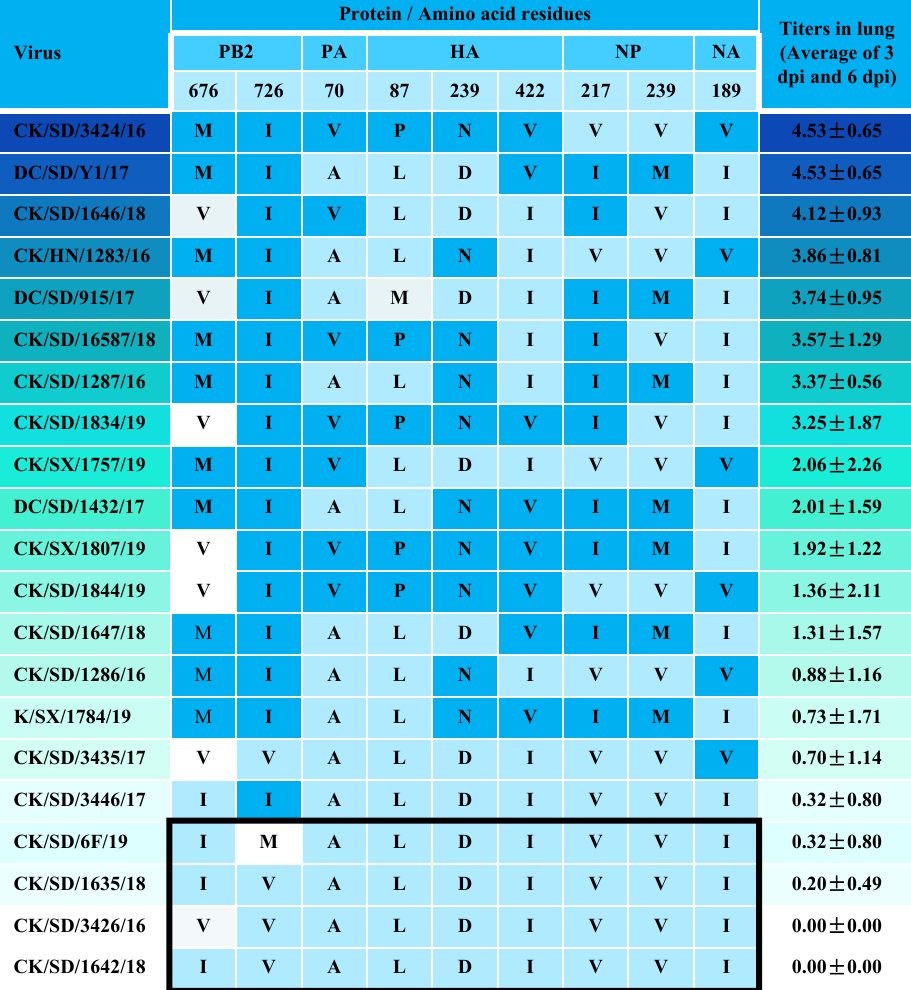
Figure 6. Amino acid residues of the H9N2 viruses that correlate with mouse replication phenotype. On the basis of viral titers at 3 dpi and 6 dpi of these H9N2 isolates in mouse lung, detailed analysis and comparison of deduced amino acid sequences from eight segments of H9N2 AIV were carried out. Dark blue represents viruses that replicate well in mice. Light blue represents viruses that replicate slowly in mice. Capital letters stand for amino acid abbreviations. M: Methionine, V: Valine, I: Isoleucine, A: Isoleucine, P: Proline, L: Leucine, N: Asparagine, D: